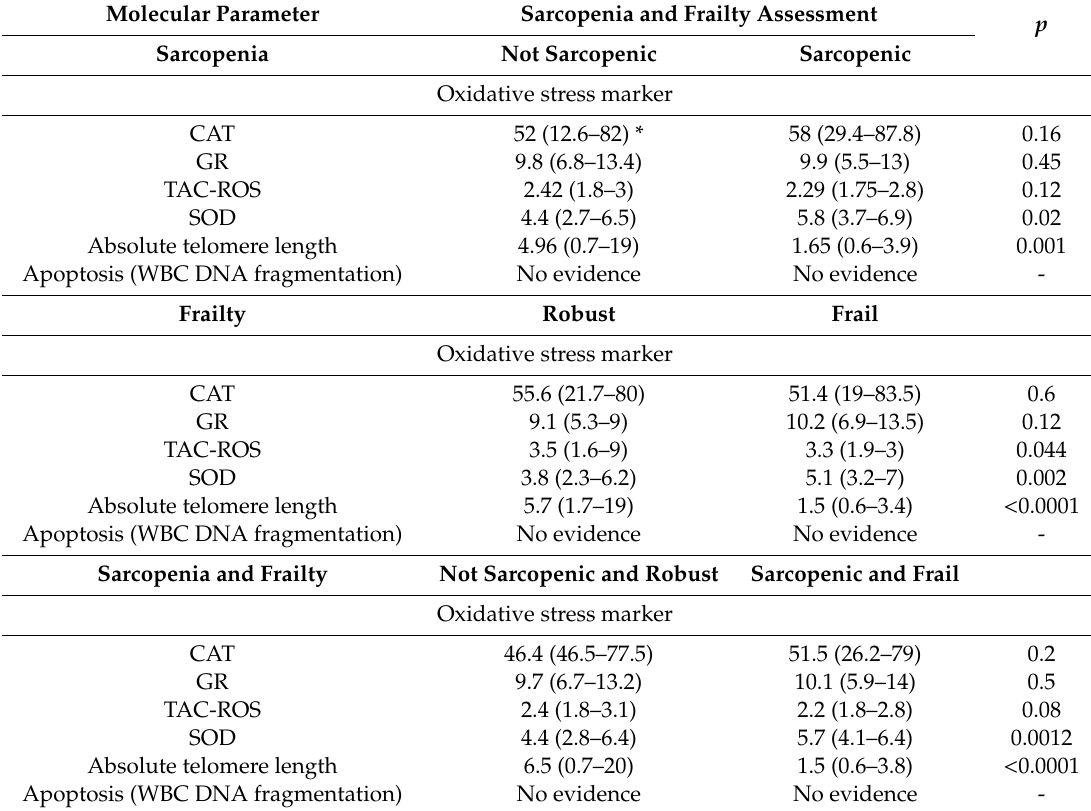
Table 2. Di ff erences of oxidative stress markers, telomere length, and apoptosis markers in patients with multimorbidity according to their sarcopenia and frailty